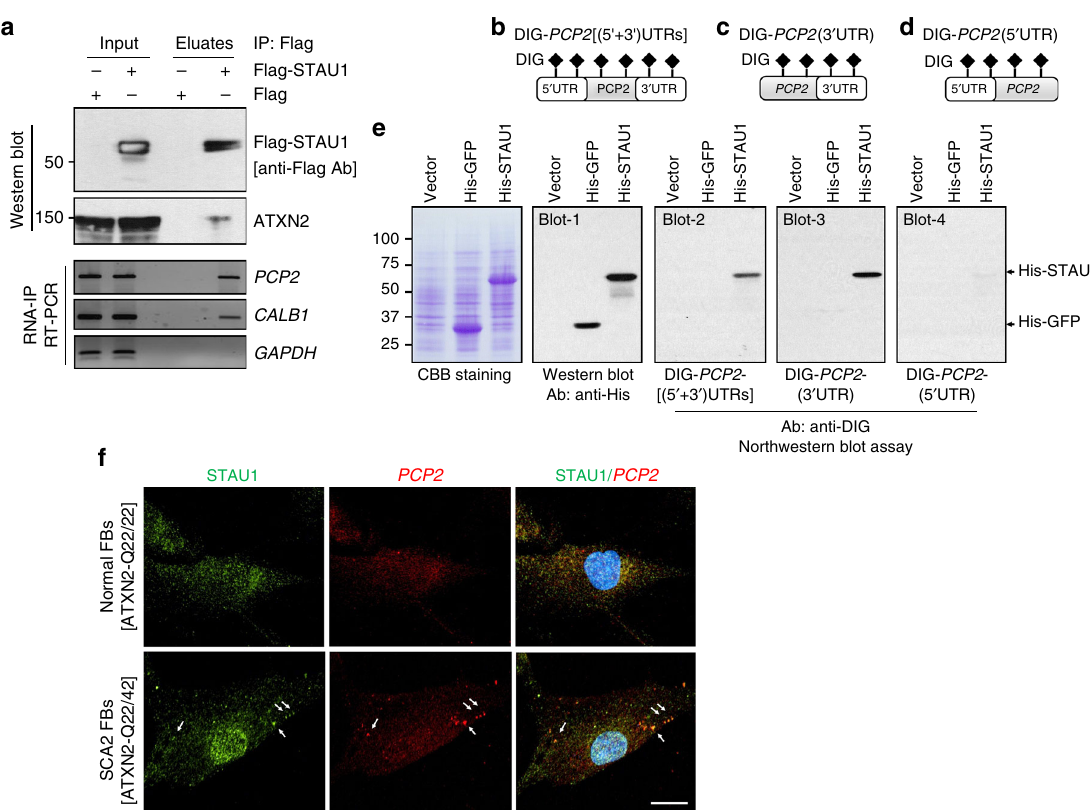
Fig. 5 STAU1 directly interacts with human PCP2 mRNA. a Non-RNase A treated HEK-293 whole-cell extracts expressing Flag or Flag-STAU1 were subjected to immunoprecipitation with Flag mAb beads. Flag-STAU1 pulled down ATXN2 protein, and PCP2 and CALB1 mRNAs on western blot and RT-PCR analysis. b – e Northwestern blotting showing that STAU1 binds directly to human PCP2 RNA in a manner requiring the 3 ′ UTR. Construction of DIG-labeled human PCP2 RNA probes with both UTRs ( b ), 3 ′ UTR only ( c ), and 5 ′ UTR only ( d ). e Bacterial expressed His-STAU1, His-GFP, or control bacterial lysate (vector alone) were run on SDS – PAGE and stained with Coomassie brilliant blue (CBB) or western blotted with anti-His antibody (blot 1). Protein blots were hybridized with DIG-labeled PCP2 RNA probes followed by anti-DIG antibody staining. STAU1 directly interacts with PCP2 RNAs: ( 5 ′ + 3 ′ )UTRs (blot 2) or 3 ′ UTR (blot 3), but not with PCP2(5 ′ UTR) RNA (blot 4). His-GFP shows no interactions. The blot represents one of three independent experiments. f STAU1- PCP2 RNA granules in SCA2 cells. Normal and SCA2 FBs were immunostained with STAU1 antibodies and STAU1 granules (green) are visualized in SCA2 FBs but not in normal FBs. PCP2 RNA granules (red) in SCA2 FBs were detected by FISH using a PCP2 -Cy3 probe. Merged images demonstrate positive STAU1- PCP2 RNA granules (white arrows) for SCA2 FBs. Scale bar, 30 µ